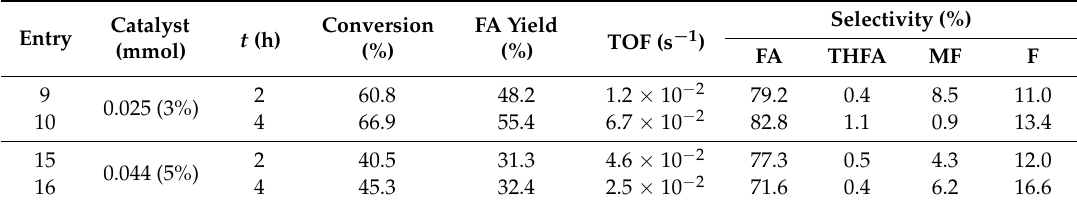
Table 2. Furfural hydrogenation results using Pt/BC 3 and 5 wt % as catalyst.